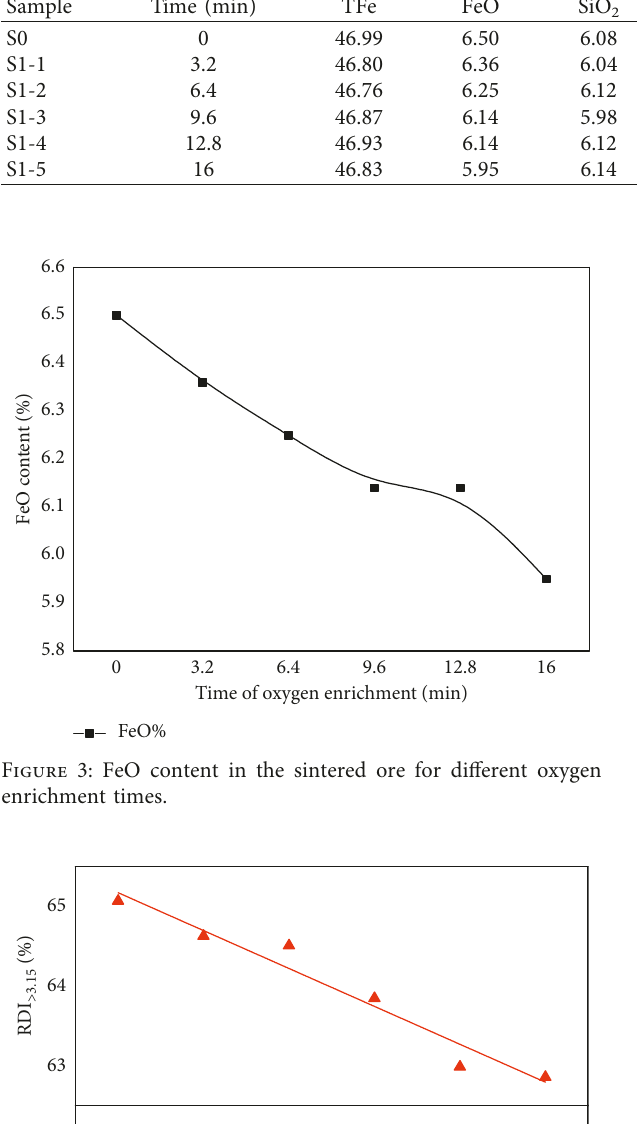
Table 6: Analysis of the composition of the finished sintered ore for different oxygen enrichment times. Sample